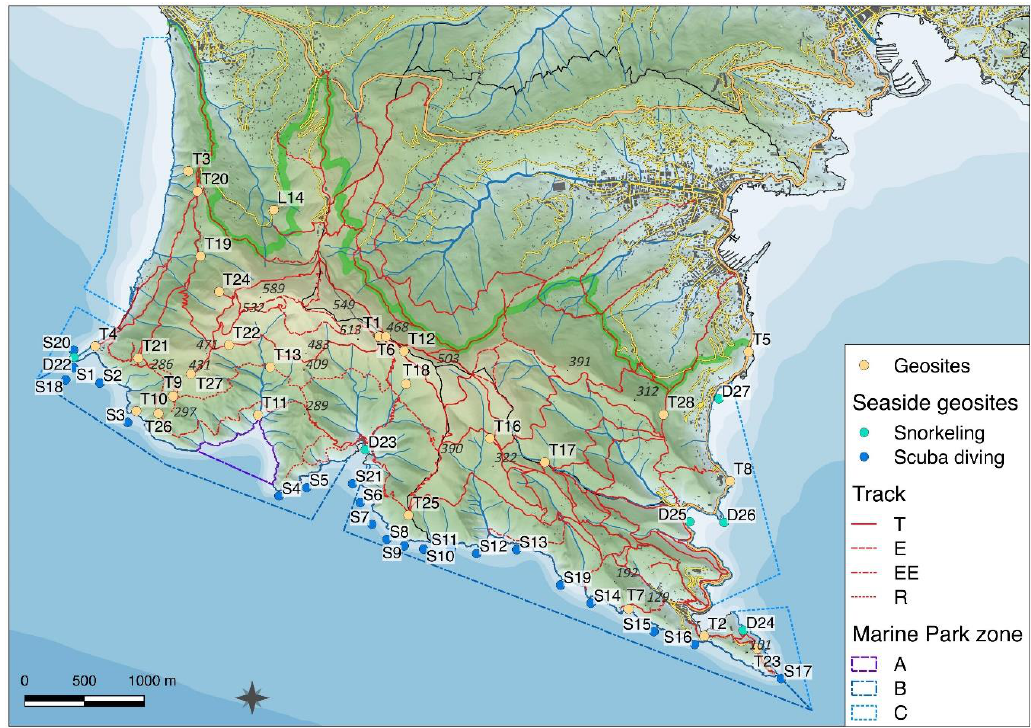
Figure 4. Location of terrestrial and marine geosites.